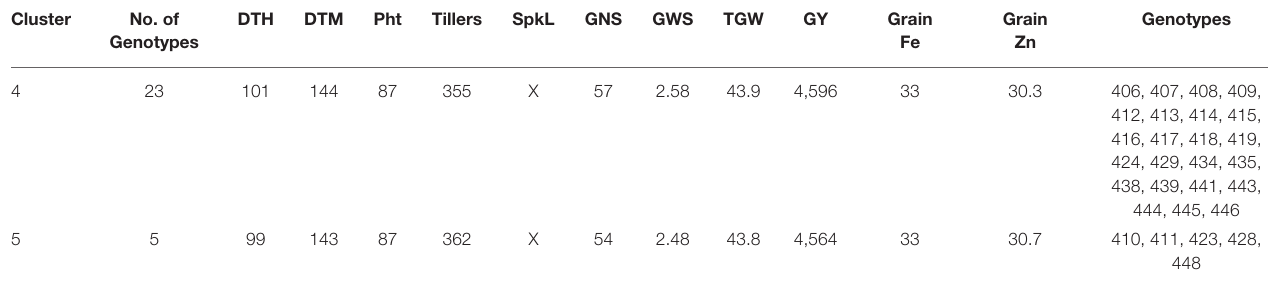
found for days to heading (0.85), days to maturity (0.65), plant height (0.76), grain zinc concentration (0.81), and grain iron concentration (0.56), while moderate heritability was found for grain yield (0.33) and thousand grain weight (0.21). High genetic advance as a percentage of mean was found for grain iron concentration (50%), days to heading (24%), and grain yield (20%) ( Table 2